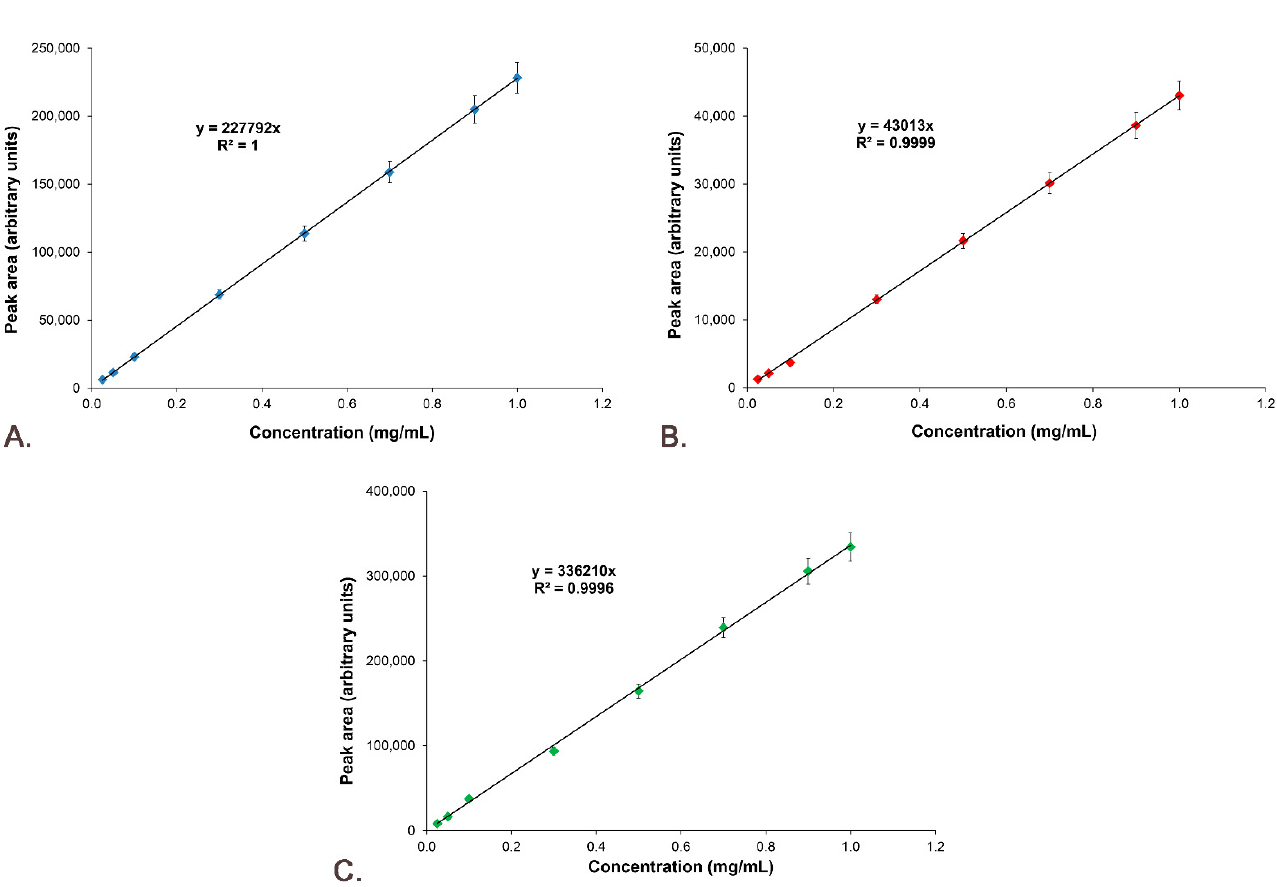
Figure 9. Standard calibration curves: ( A ) Sil A; ( B ) Sil B; ( C ) Gli.